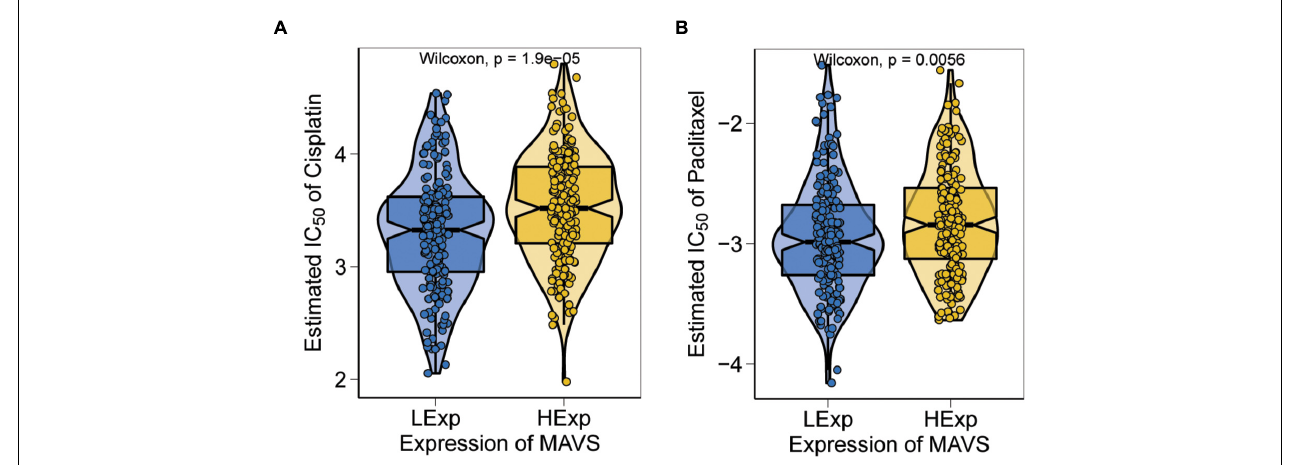
FIGURE 7 | Sensitivity analysis based on MAVS expression. The high MAVS expression group was predicted significantly less respond to cisplatin ( P = 0.000; A ) and paclitaxel ( P = 0.0056; B ),